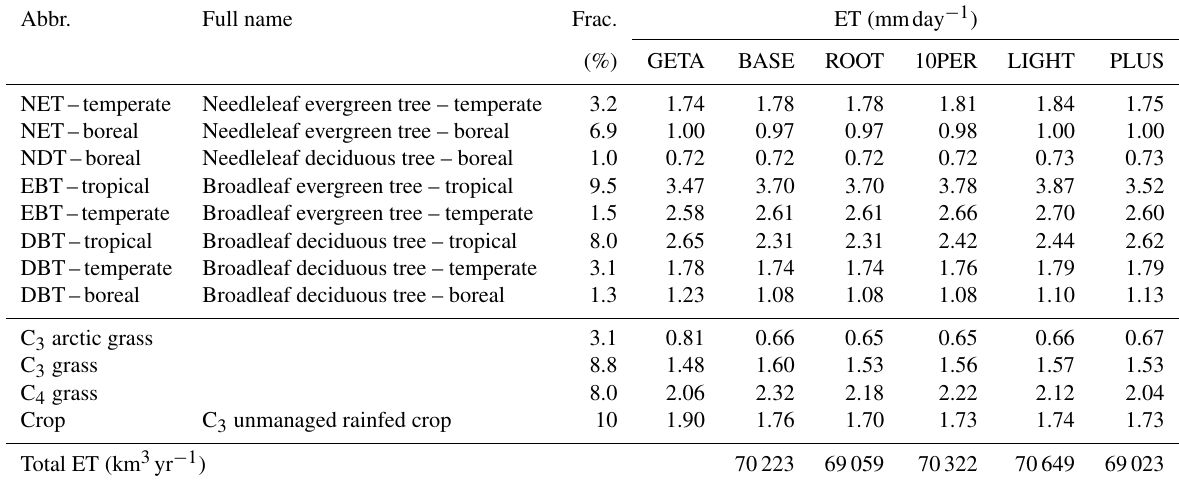
Total ET (km 3 yr − 1